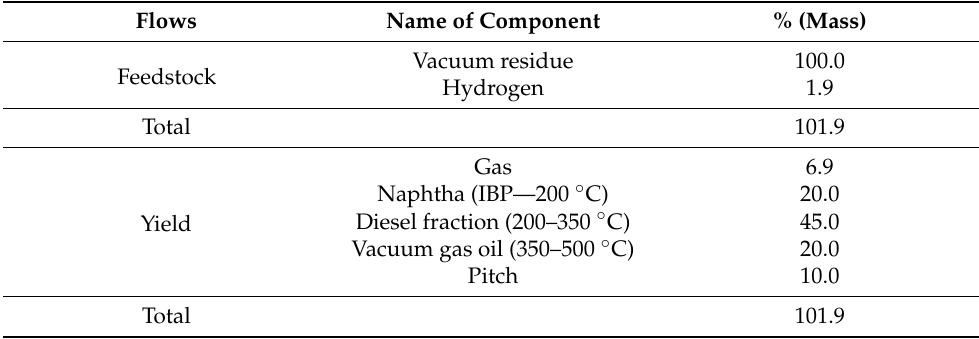
Table 2. Material balance of Uniflex.